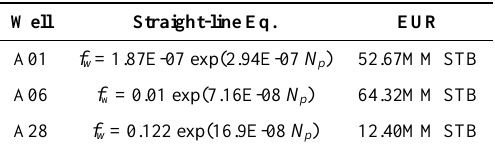
Figure 13. Fractional flow of water versus cumulative oil production for well A28 Table 4. EUR from Log ( f w ) versus N p